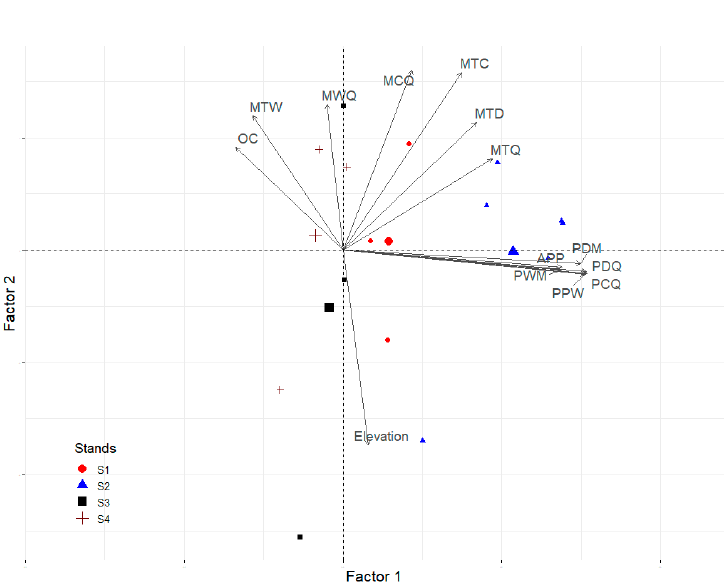
Figure 3. PCA biplot based on the main environmental variables extracted from the WorldClim and SoilGrids databases and topographic variables per stand.